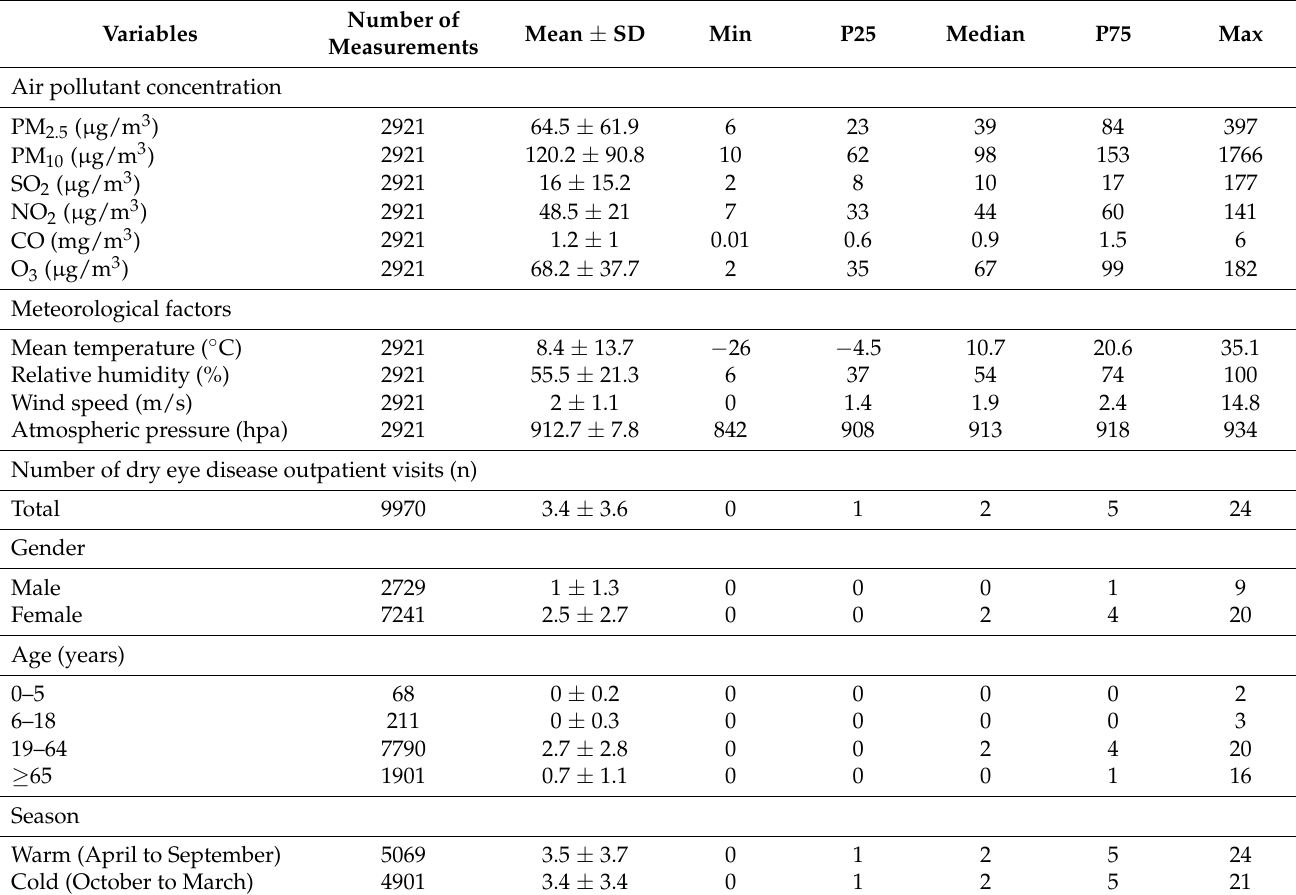
Table 1. Characteristics of outpatients for dry eye disease (DED) in the First Affiliated Hospital